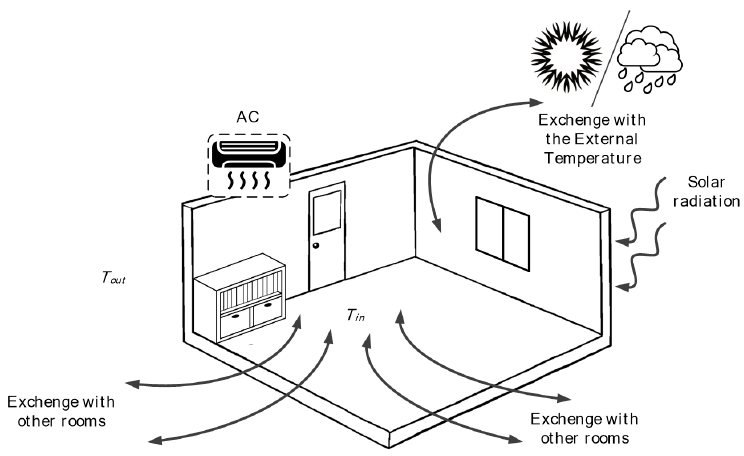
Figure 6. The representation of the indoor temperature control.